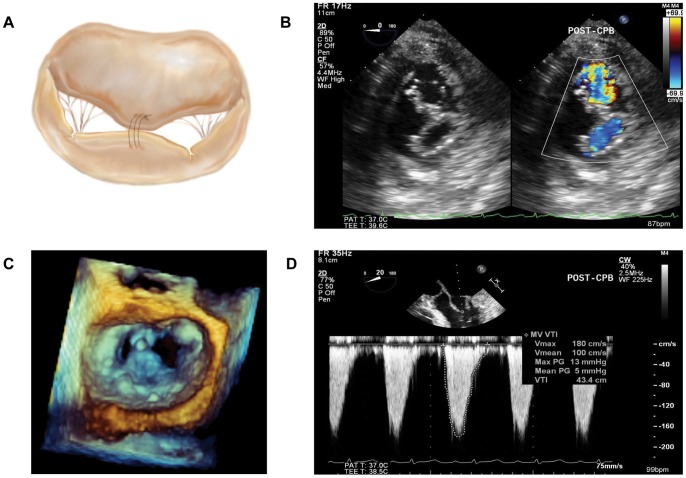
Edge-to-edge repair of the mitral valve.(A) Drawing of a central edge-to-edge (Alfieri) repair shown from the surgeons' perspective. (B) Two dimensional transesophageal echocardiographic (TEE), transgastric short axis view after edge-to-edge repair highlighting the double-orifice geometry in B-mode and Color Doppler echocardiography. (C) Still image of the mitral valve after edge-to-edge repair captured from a three-dimensional TEE, full volume data set shown en-face from the left atrial perspective. (D) Measurement of peak and mean transmitral mitral pressure gradient (TMPG) obtained with continuous-wave Doppler from the midesophageal four-chamber view following an edge-to-edge repair.